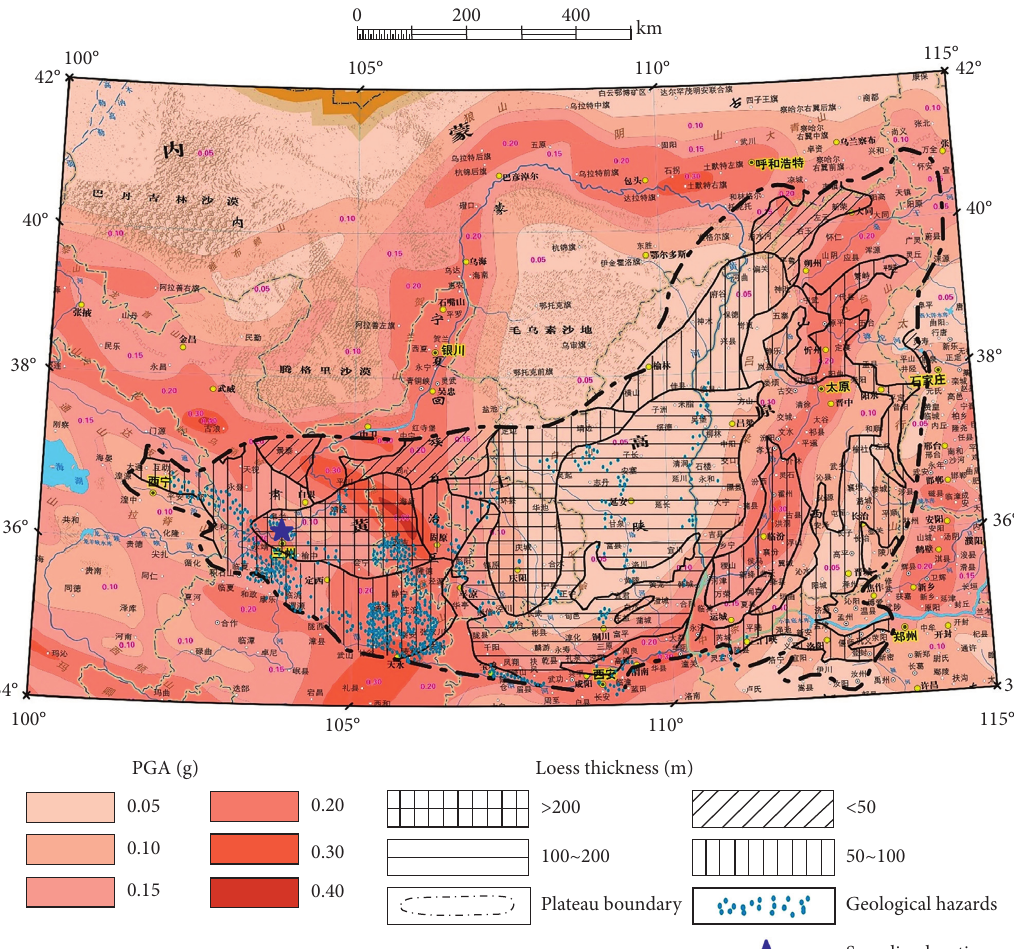
Figure 1: Loess thickness, seismicity risk, and historical geological hazard